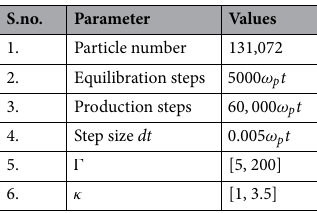
Table 1. List of simulation parameters in normalised